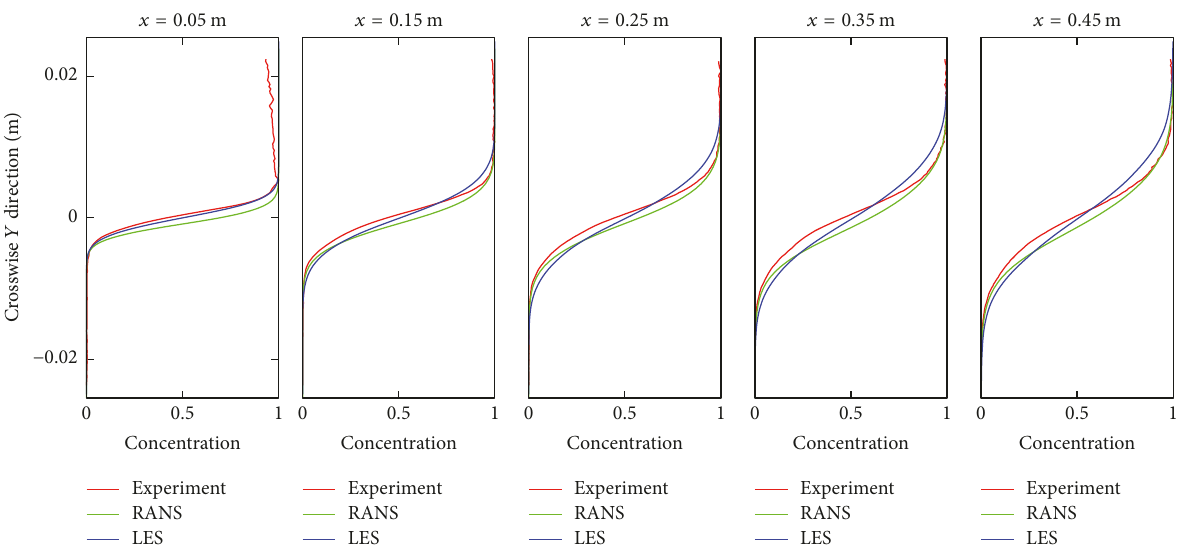
Figure 13: Concentration profiles at different locations for the two-liquid